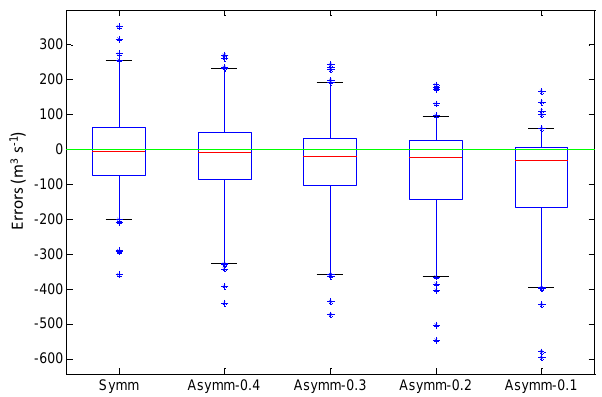
Figure 4. Parallel box plots of the errors ( ε = Q 2,p − Q 2,o ) of the 2-year floods estimates obtained by symmetric and asymmetric net- works on the independent test set of catchments. The bottoms and tops of the rectangular boxes are respectively the lower and the up- per quartiles, the horizontal segment inside the box is the median and the whiskers represent the 5th and 95th